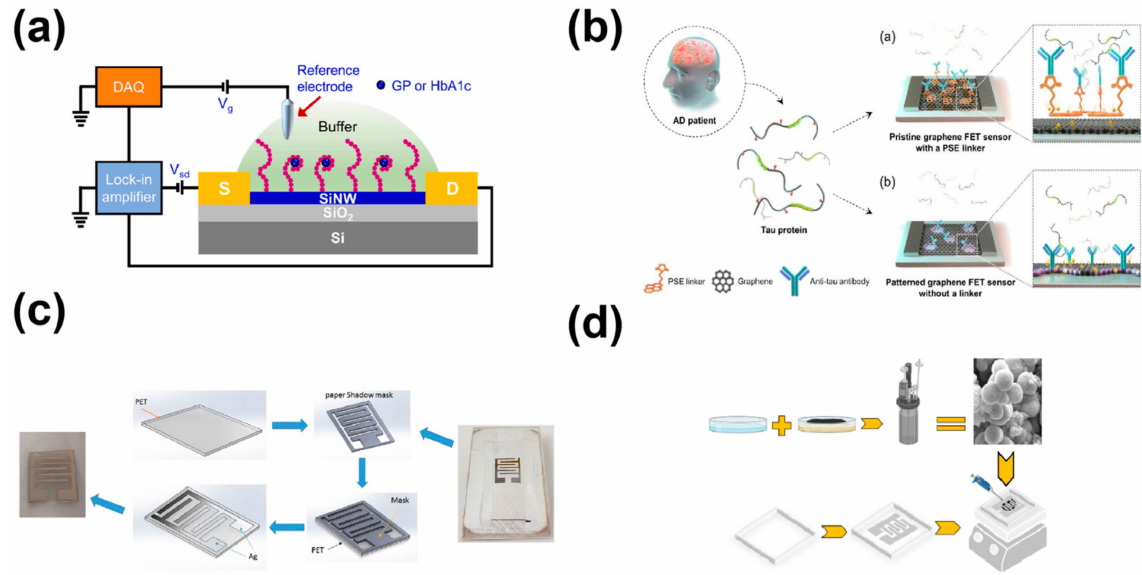
Figure 11. ( a ) Surface modification of multiple-parallel-connected (MPC) SiNW-FET requires the modification of mercap topropyltrimethoxy-silane (MPTMS), peg-silane and PTMS on the surface of SiNW, and then a silyl molecular layer with sulfhydryl, hydroxyl and methyl groups is formed, and then Apt GP is modified on MPTMS through the action of disulfide bonds. (The source is denoted by S and the drain by D). ( b ) The initial graphene state and the patterned graphene state with the pyrenebutanoic acid, succinimidyl ester (PSE) connector. ( c ) A step diagram of a silver electrode was modified on a shadow mask plate with PET as the base. ( d ) The process diagram of making the material and the schematic diagram of the reduced graphene oxide (rGO)/CuO-NHS sensor. ( a ) Reproduced with permission [82]. Copyright 2021, John Wiley and Sons. ( b ) Reproduced with permission [83]. Copyright 2021, Elsevier. ( c ) Reproduced with permission [85]. Copyright 2022, Springer Nature. ( d ) Reproduced with permission [85]. Copyright 2022, Springer